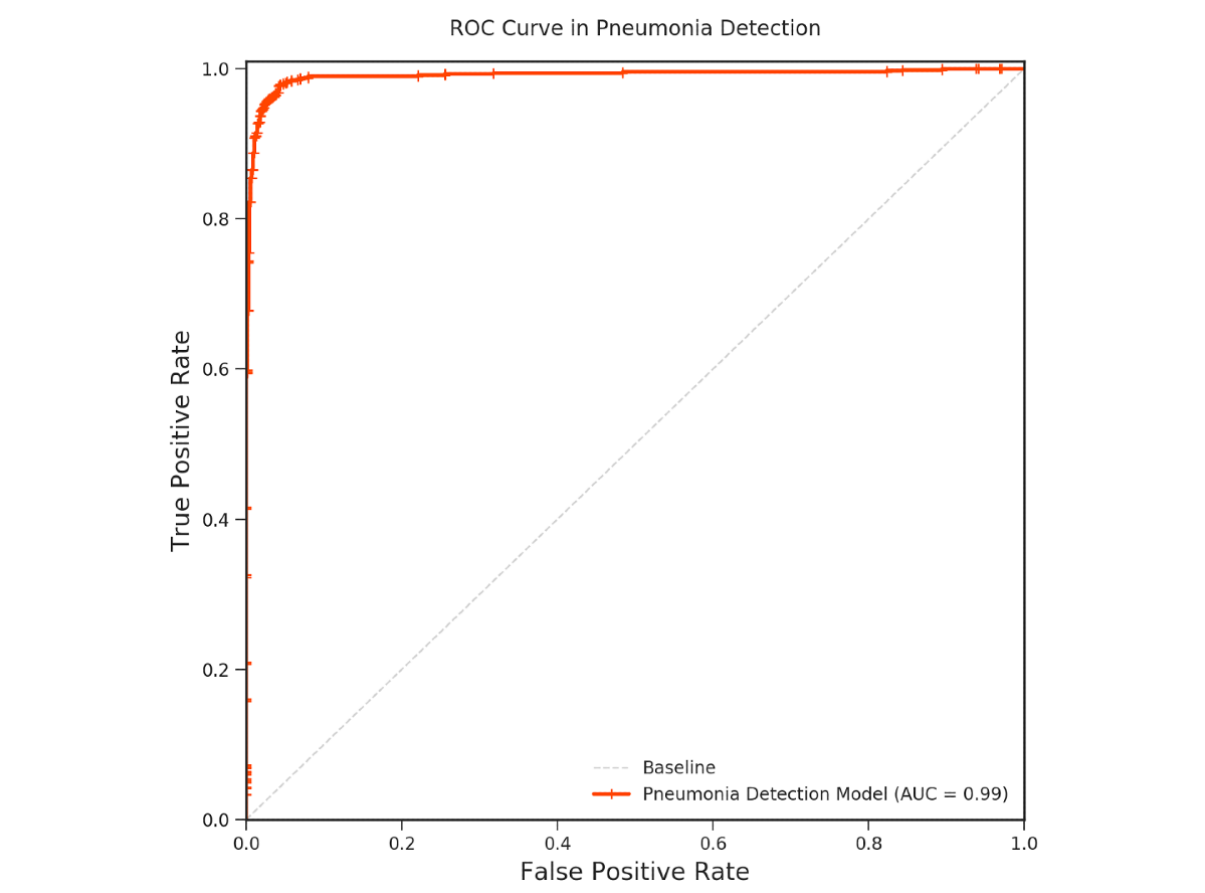
Figure 7. AUC of the AI chest x-ray interpretation system for recognizing pulmonary infiltrates on chest x-rays. AUC: area under the ROC curve; ROC: receiver operating